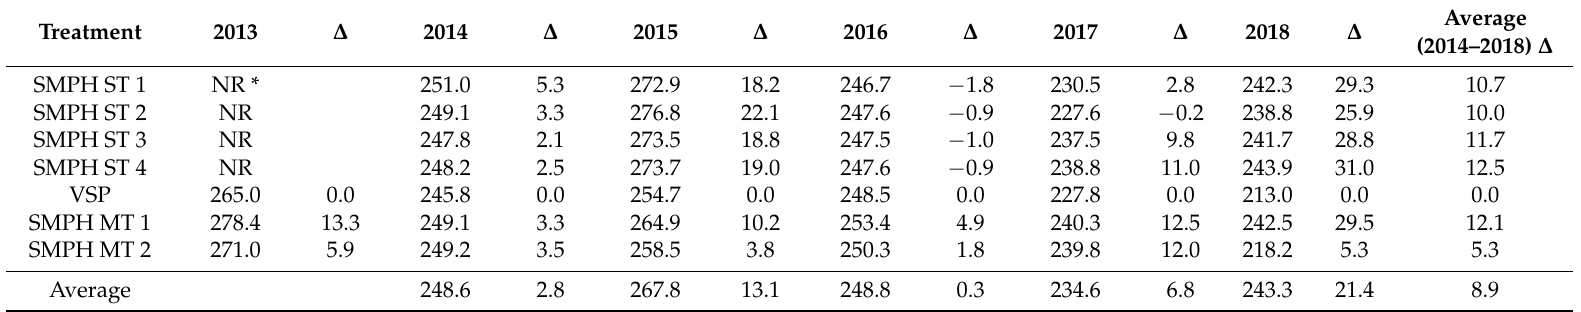
Table 2. Calculated dates (day of the year (DOY)) for reaching 14.12 brix between 2013 and 2018 as well as deviations ( ∆ ) between the DOY for reaching 14.12 brix in one treatment in a specific year and the DOY for reaching 14.12 in the standard treatment, VSP, in that year. Average (2014–2018) deviations of different treatments are